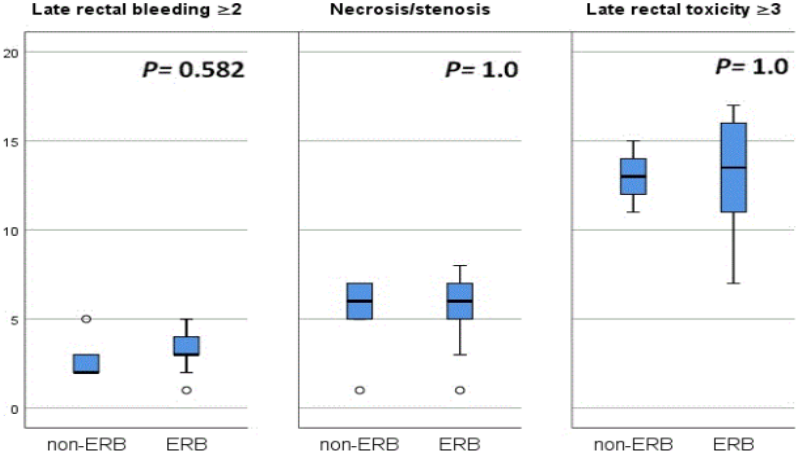
Figure 3. Blox plot comparing median and full range of variation of the rectal NTCP rates for late rectal bleeding ≥ 2, necrosis/stenosis, and late toxicity ≥ 3 for non ERB plans vs. ERB plans.